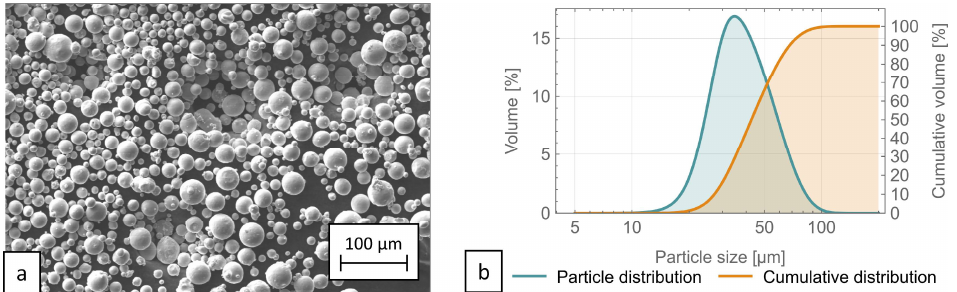
Figure 2. SEM photo ( a ) and granulometry analysis ( b ) of Ti6Al4V.